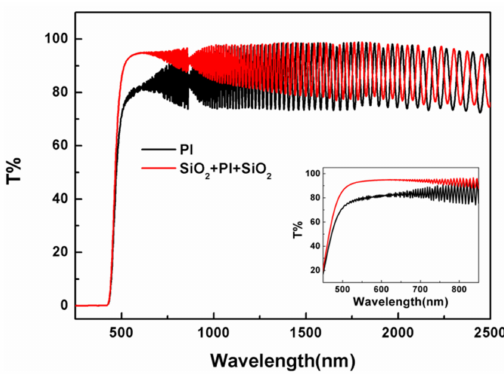
Figure 3. The transmittance spectra of PI membrane before and after coated with SiO 2 antireflective membrane on both sides. Insert picture is the enlarge part of the spectra at wavelength between 450 nm and 900 nm.